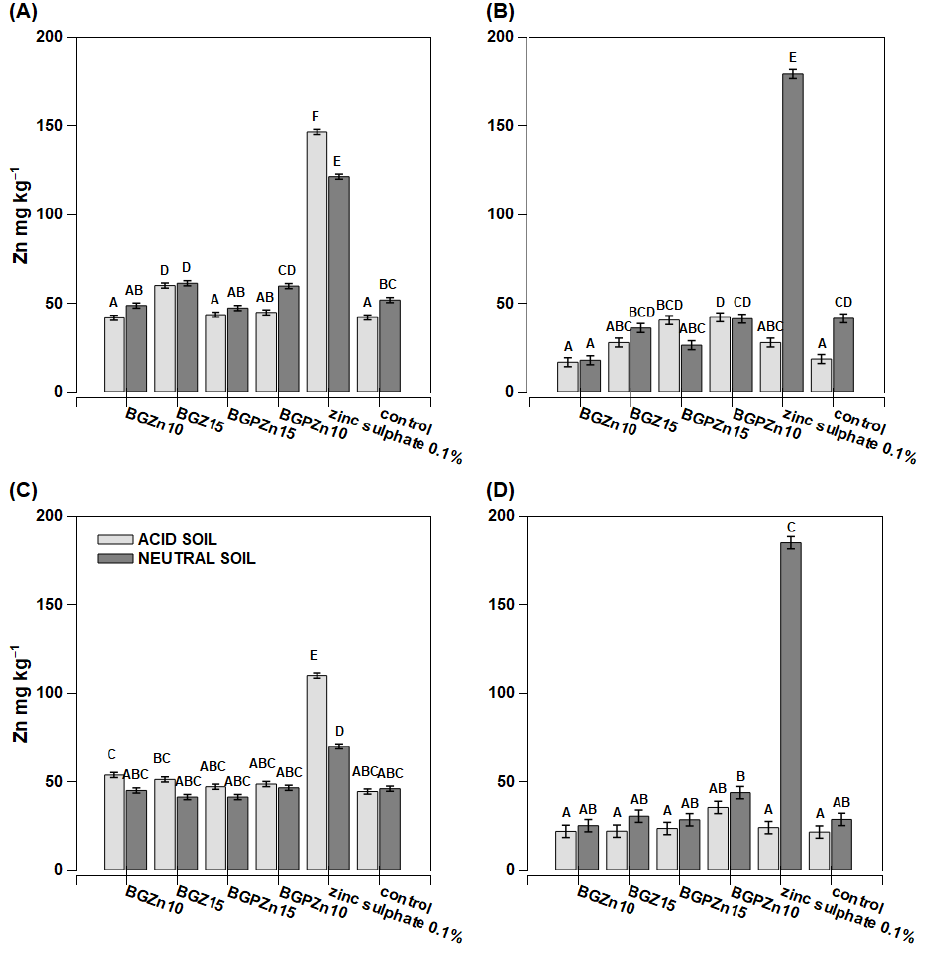
Figure 8. Zinc concentration in maize (Zea mays) plant parts after foliar application of fertilizer. Grey bars for acid, dark grey for neutral soil. Bars marked with the same letters represent homogenous groups after Tukey’s test at p < 0.05 and error bars represent standard error (n = 4). ( A ) In whole plant—preparation applied on one leaf; ( B ) in one leaf sprayed; ( C ) in whole plant sprayed; ( D ) in leaf cut from whole sprayed plant.